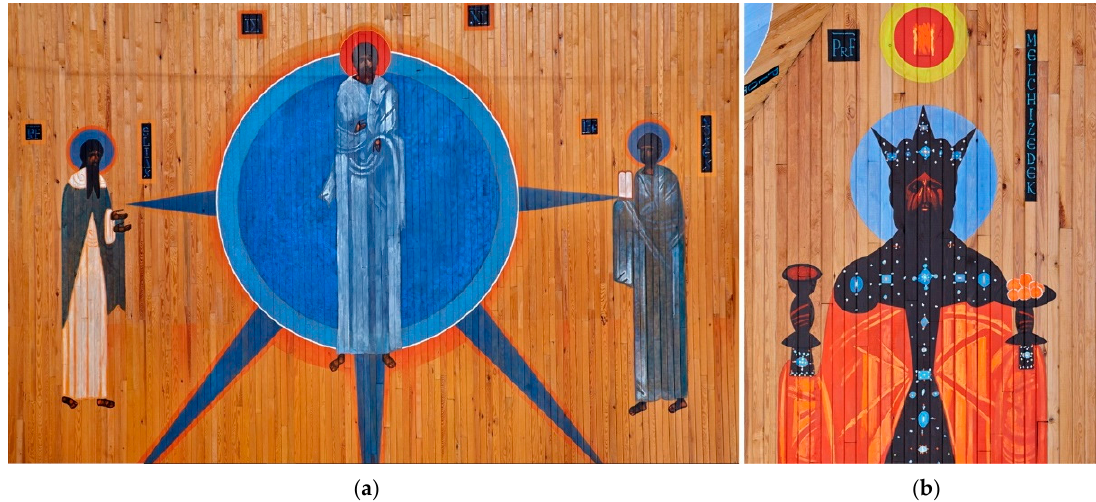
Figure 13. Church in Tychy—details of the polychromy: ( a ) Transfiguration; ( b ) Melchizedek. Photography by the author. Reproduced with permission.